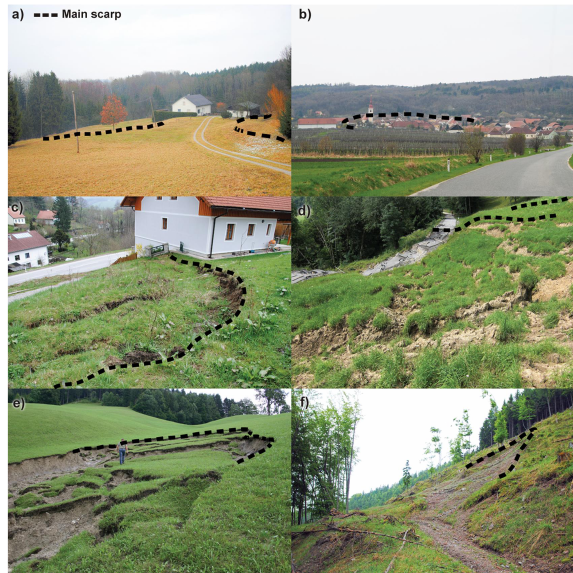
Figure 2. Examples of landslides (earth and debris slides) typical of the respective lithological 2 Fig. 2. Examples of landslides (earth- and debris slides) typical of unit (a) landslide in Molasse Zone at Strengberg, (b) the village “Waitzendorf” located on a 3 the respective lithological unit (a) landslide in Molasse Zone at landslide in Molasse with Schlier, (c) translational landslide in the Rheno-danubian Flysch 4 Strengberg, (b) the village “Waitzendorf” located on a landslide Zone at Brand (d) rotational landslide/flow in the Rheno-danubian Flysch Zone at Stössing, 5 in Molasse with Schlier, (c) translational landslide in the Rheno- (e) landslide in Austroalpine Unit (Limestone, Marls) at Dippelreith, (f) landslide in 6 danubian Flysch Zone at Brand, (d) rotational landslide/flow in Austroalpine Unit (with Dolostone) at Kleinzell. Pictures taken by: (a), (b), (c), (f) Petschko 7 the Rheno-danubian Flysch Zone at Stössing, (e) landslide in Aus- (2012, 2010, 2011, 2012), (d) Bertsch (2009), (e) BGR (2006) 8 troalpine Unit (Limestone, Marls) at Dippelreith, (f) landslide in 9 Austroalpine Unit (with Dolostone) at Kleinzell. Pictures taken by: (a) , (b) , (c) , (f) Petschko (2010, 2011, 2012); (d) Bertsch (2009); (e) BGR